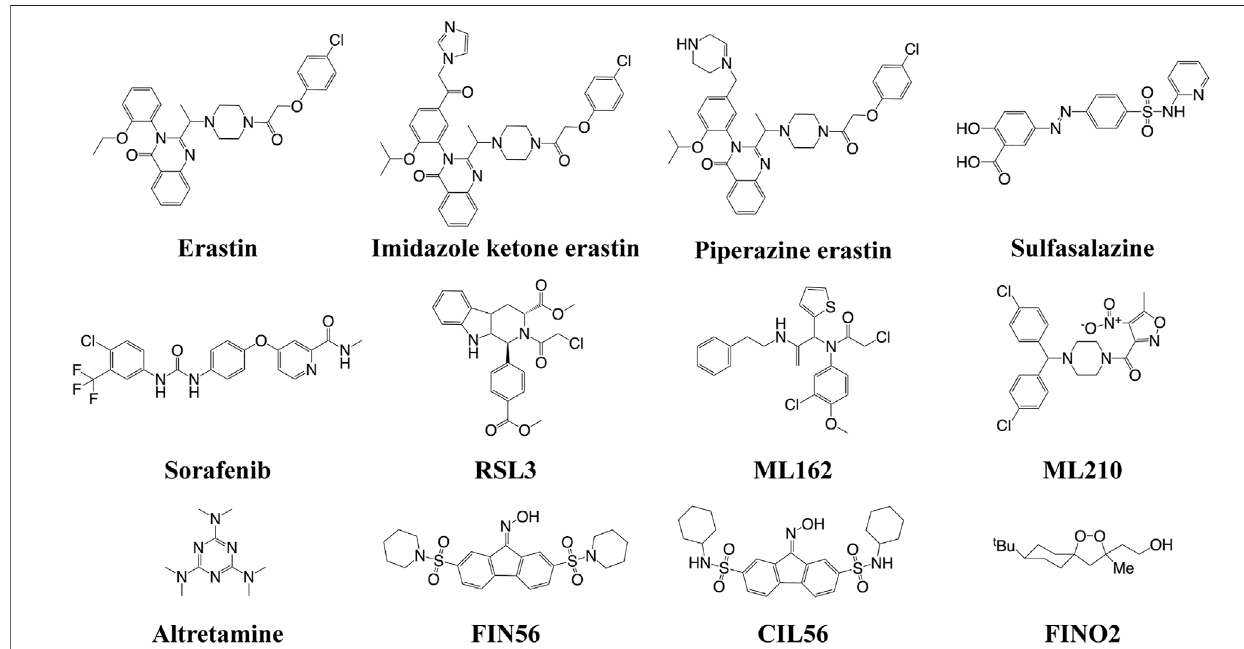
FIGURE 2 | Structures of the small-molecule ferroptosis